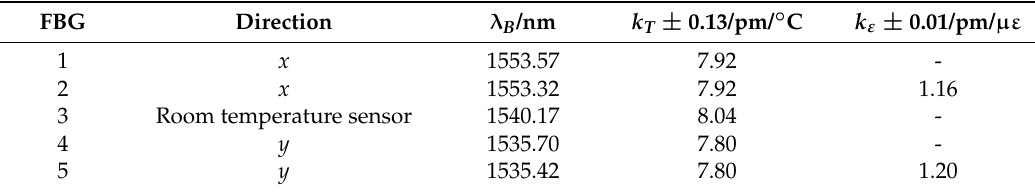
Table 1. Temperature and strain sensitivities of the FBG